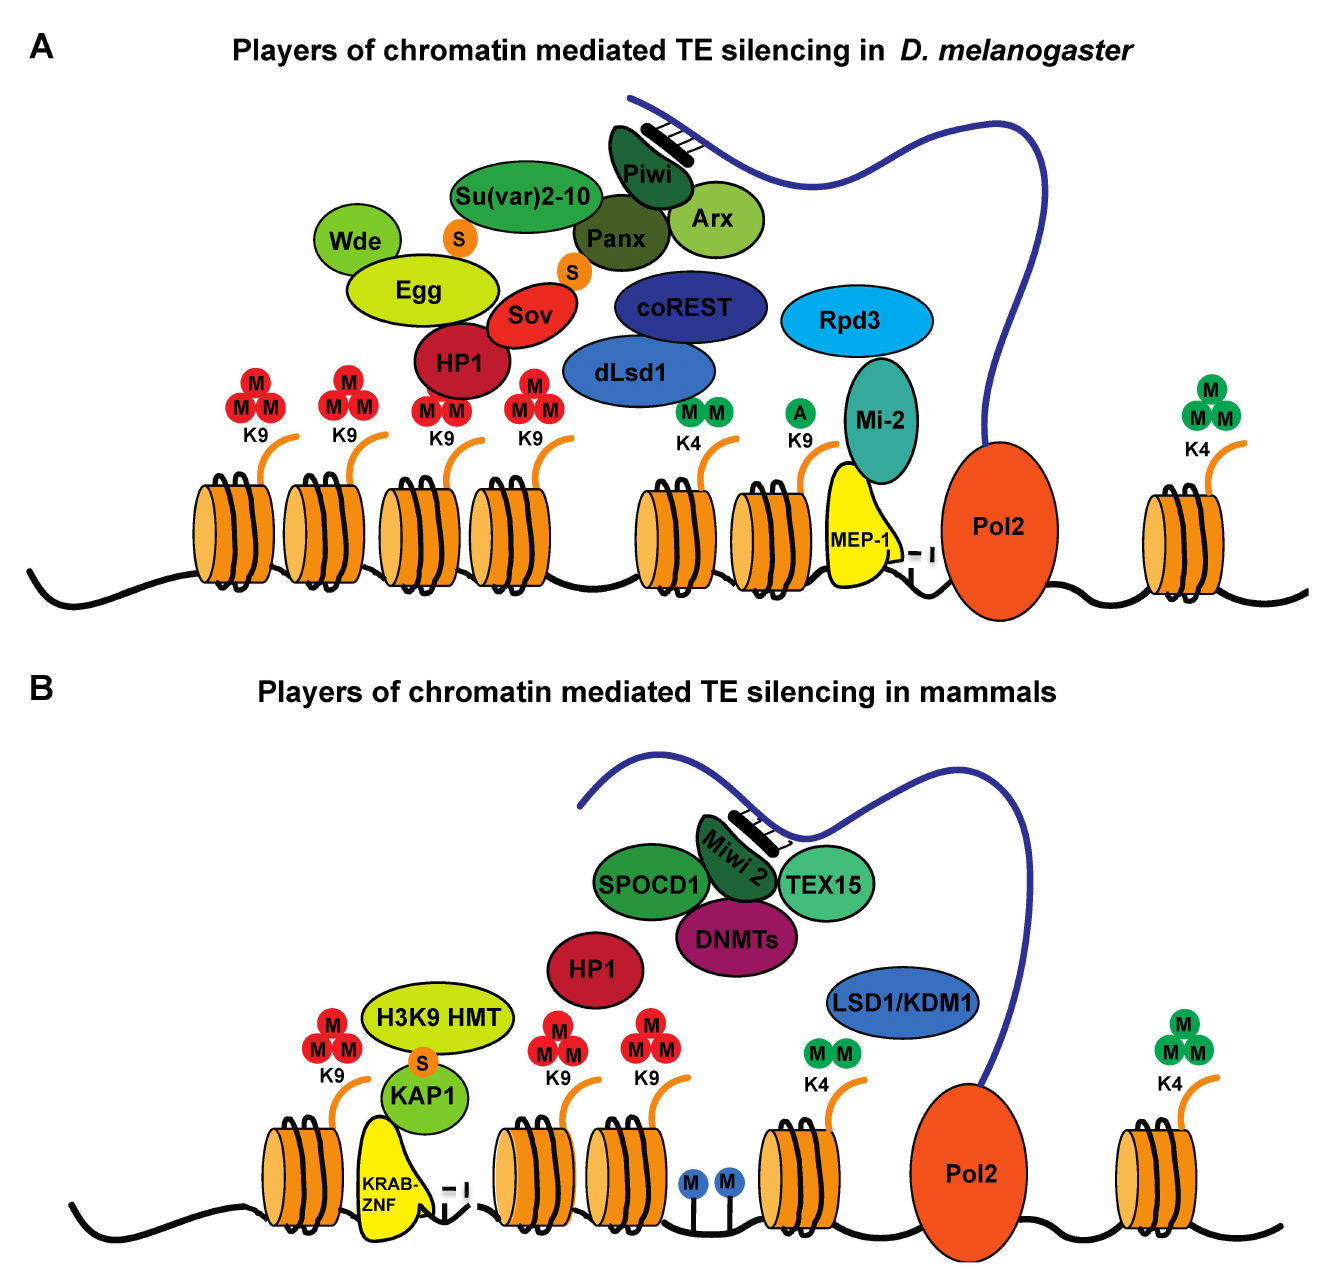
Figure 4. Models of chromatin-mediated transposon-silencing mechanisms. ( A ) Schematic repre- sentation of the factors implicated in TE silencing in Drosophila ( B ) and in mammals. Multiple mechanisms exist to repress TEs both in flies and in mice, including piRNA-directed silencing me- diated by the Piwi/MIWI2-piRNAs complex, DNA methylation-dependent silencing mediated by DNMTs (in mammals), KDM1a-dependent histone demethylation and KRAB-ZNF-KAP1-mediated silencing. Whether these layers of control of TE silencing collaborate on the same TEs or act on different TEs or in different cell types/tissues remains to be fully